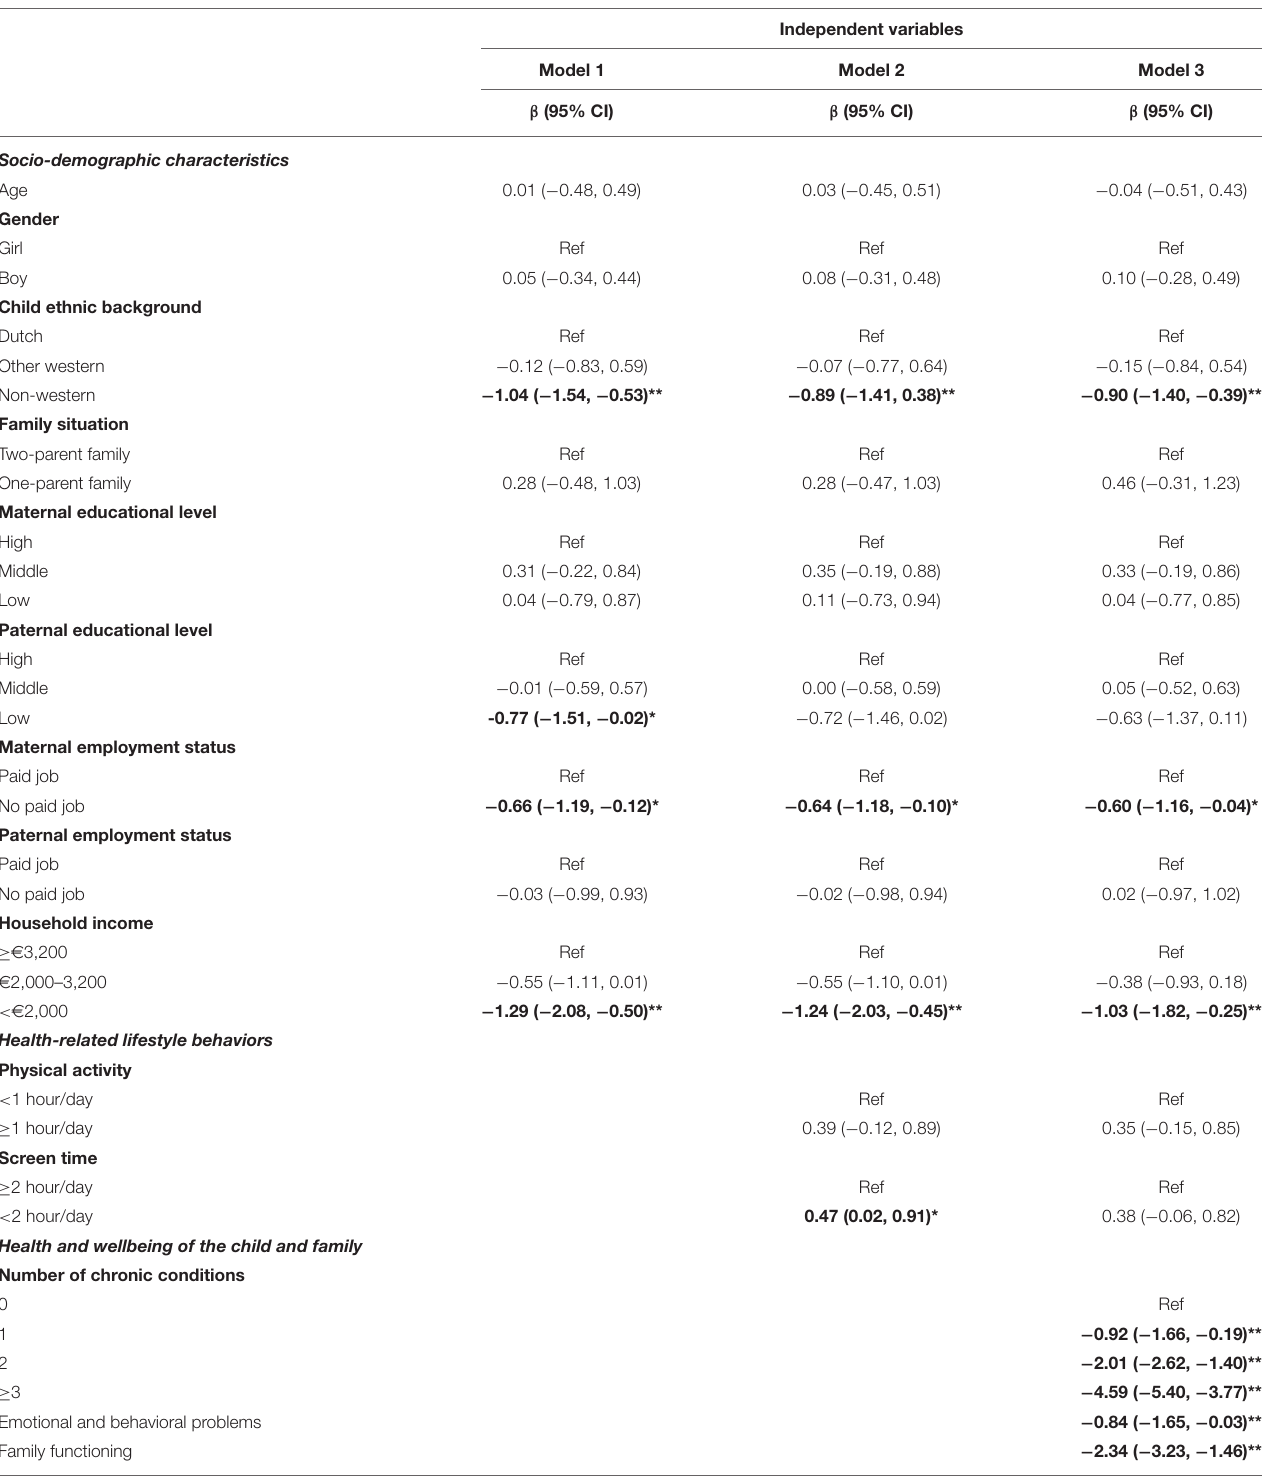
TABLE 2 | Multivariate analyses of socio-demographic characteristics, health-related lifestyle behaviors, and health and well-being of the child and family with physical summary score